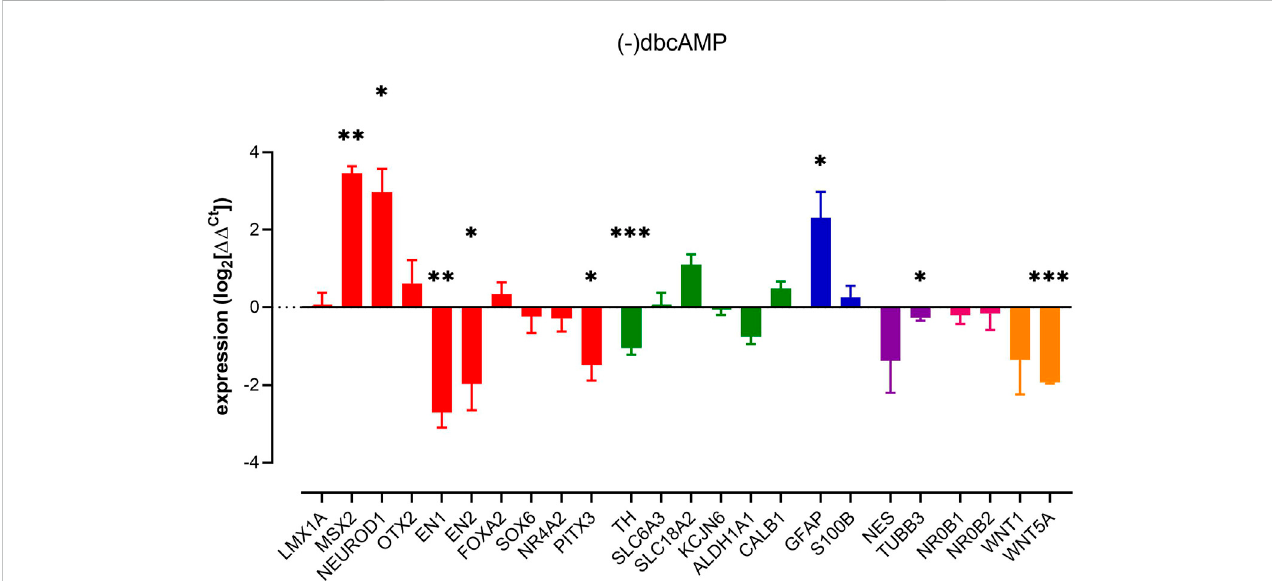
FIGURE 1 Impact of removal of dbcAMP upon pluripotent stem cell-derived dopaminergic neuron cultures. Columns show mean (+s.e. mean) data normalized to HPRT1 and TBP and expressed as fraction of (+) dbcAMP control (from matched differentiations). Statistical analysis was via one sample t-tests ( n = 3 – 6 biological replicates). Graphs show mean +/- s. e. mean changes; * = p < 0.05, ** = p < 0.01 and *** = p <